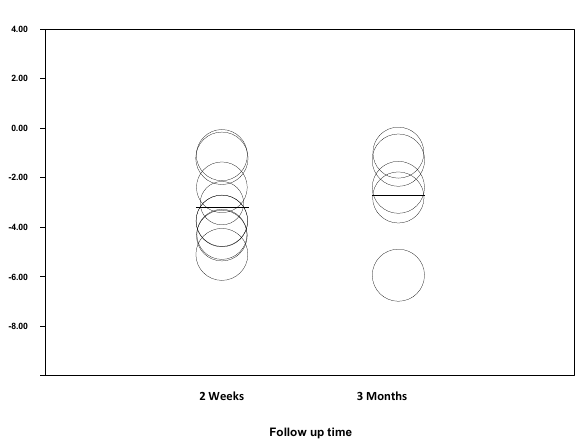
Figure 6. Subgroup meta-regression.